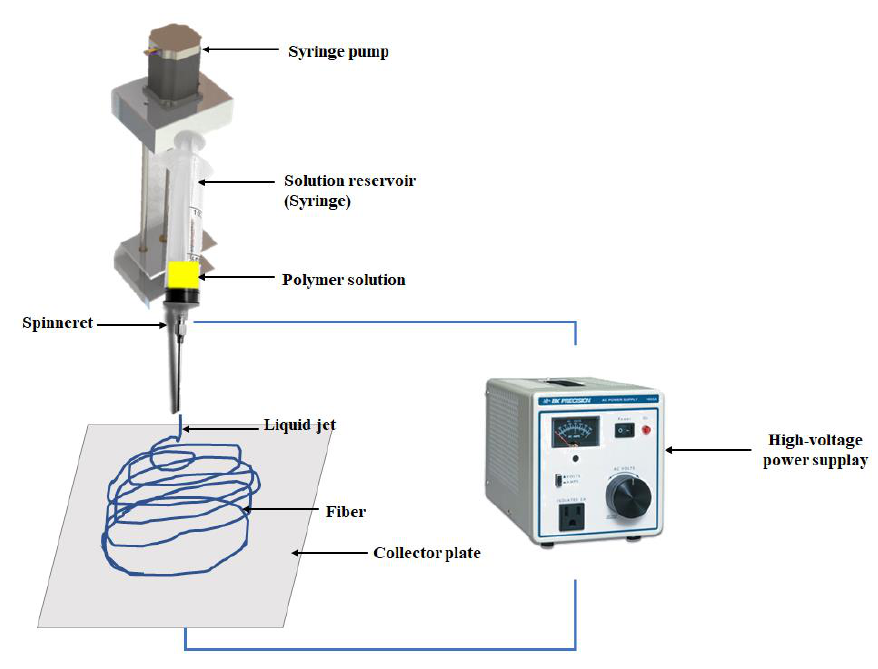
Figure 1. Schematic representation of electrospinning.